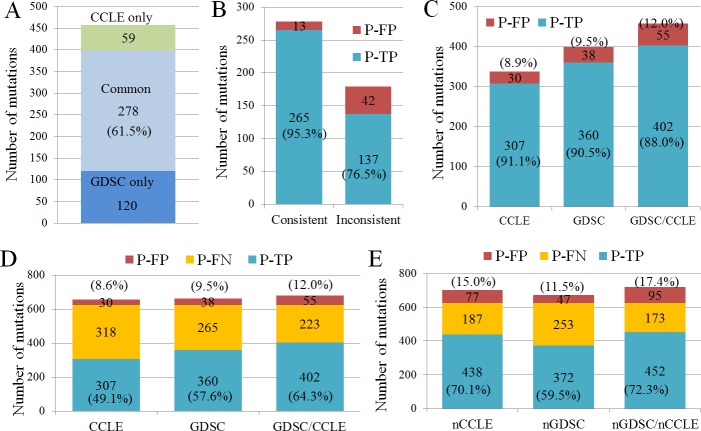
Estimation of error rates in mutation calls from CCLE and GDSC.A. Comparison of mutation calls between CCLE and GDSC for 151 genes in 35 cell lines. The consistency between GDSC and CCLE was 61.5%. B. Mutation detection rates in consistent and inconsistent mutation calls between GDSC and CCLE for 151 genes in 35 cell lines. Almost all of the consistent calls (“Consistent” on X-axis, 95.3%) and 76.5% of the inconsistent calls (“Inconsistent” on X-axis) between the two databases were positive (P-TP) in our T-NGS. C. P-FP call rates in GDSC and CCLE databases along with combined data from GDSC and CCLE databases (GDSC/CCLE). D. P-FP and P-FN mutation call rates in CCLE, GDSC, and combined data from GDSC and CCLE (GDSC/CCLE). E. P-FP and P-FN mutation call rates in later versions of CCLE (nCCLE) and GDSC (nGDSC), or in the combined data from later versions of GDSC and CCLE (nGDSC/nCCLE). P-TP, possibly true positive; P-FP, possibly false positive; P-FN, possibly false negative.